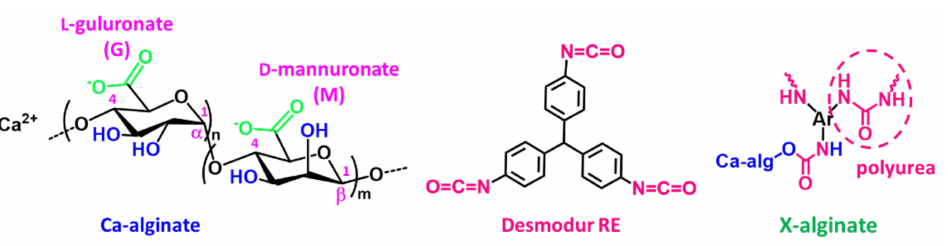
Figure 1. The structures of Ca-alginate, triphenylmethane-4,4 (cid:48) ,4 (cid:48)(cid:48) -triisocyanate (TIPM; Desmodur RE) and the corresponding X-alginate aerogels. Ca-alginate is a block copolymer of β -(1 → 4)-linked D-mannuronate (M) and α -(1 → 4)-linked L-guluronate